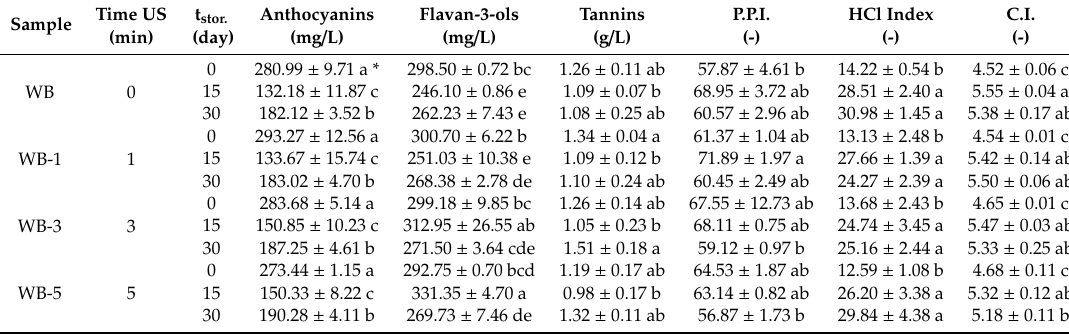
Table 5. E ff ect of ultrasound time and storage time on anthocyanins, flavan-3-ols, tannins content, polymerized pigments index (P.P.I.), HCl index, and color intensity (C.I.) of red wine B. Time US t stor. Anthocyanins Flavan-3-ols Sample